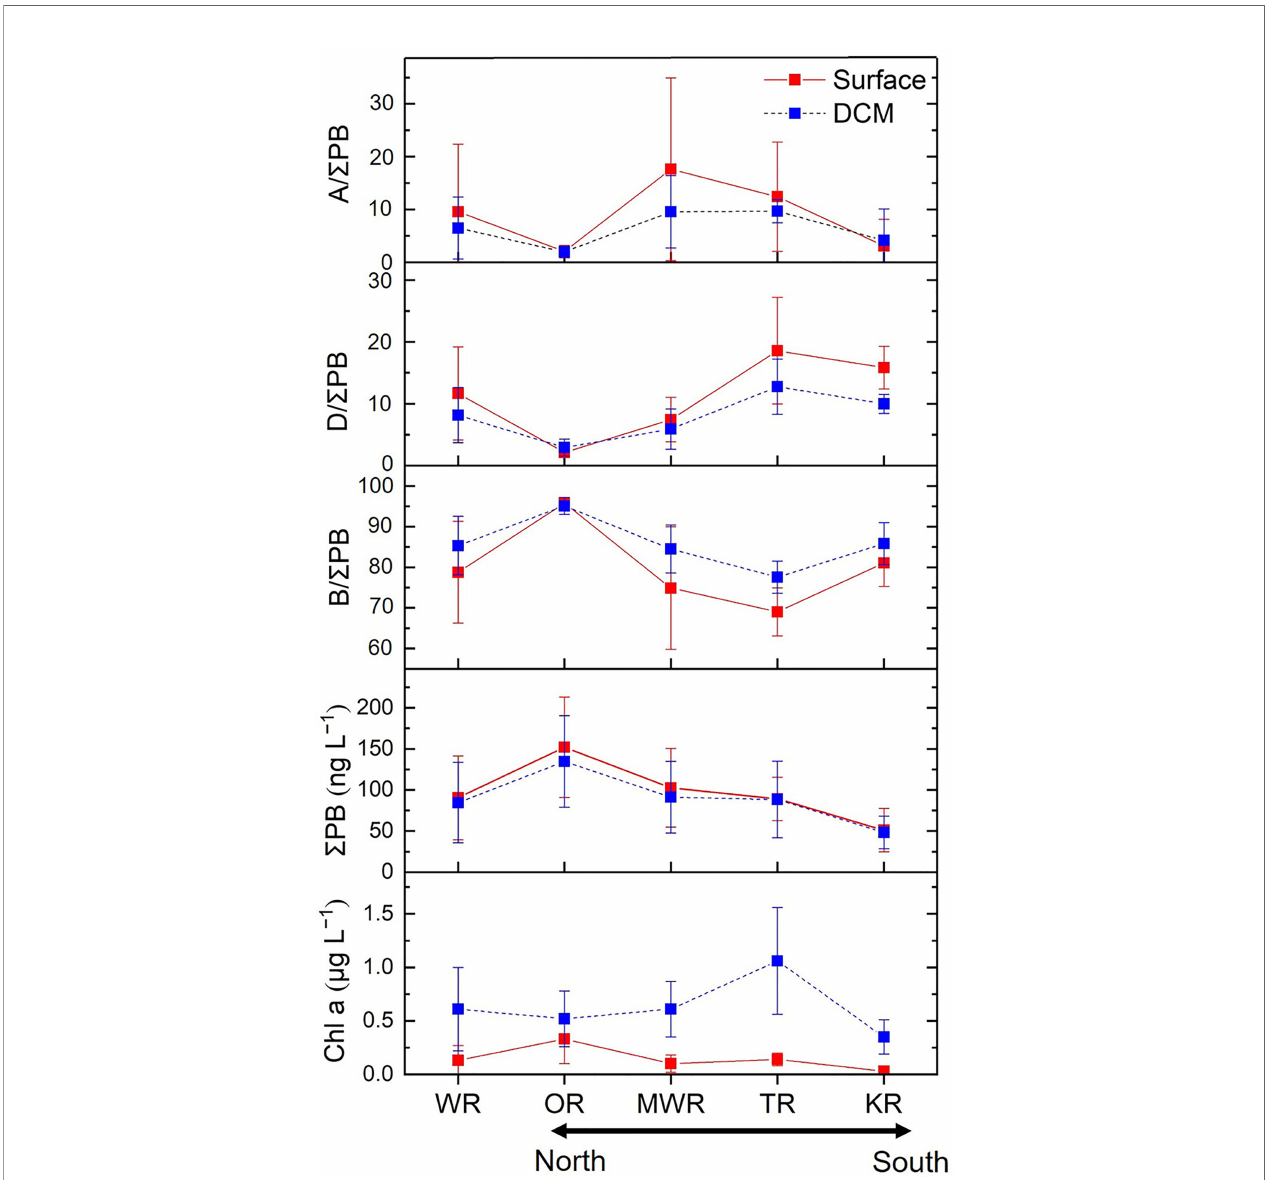
FIGURE 5 | Mean values (± SD) of individual lipid biomarker proportions (%), S PB concentrations (the sum of the three lipid biomarkers; ng L − 1 ) and chlorophyll a concentrations ( m g L − 1 ) in surface and DCM waters of the four regions and the whole study area (WR). OR, Oyashio Region; MWR, Mixed Water Region; TR, Tsushima Region; KR, Kuroshio